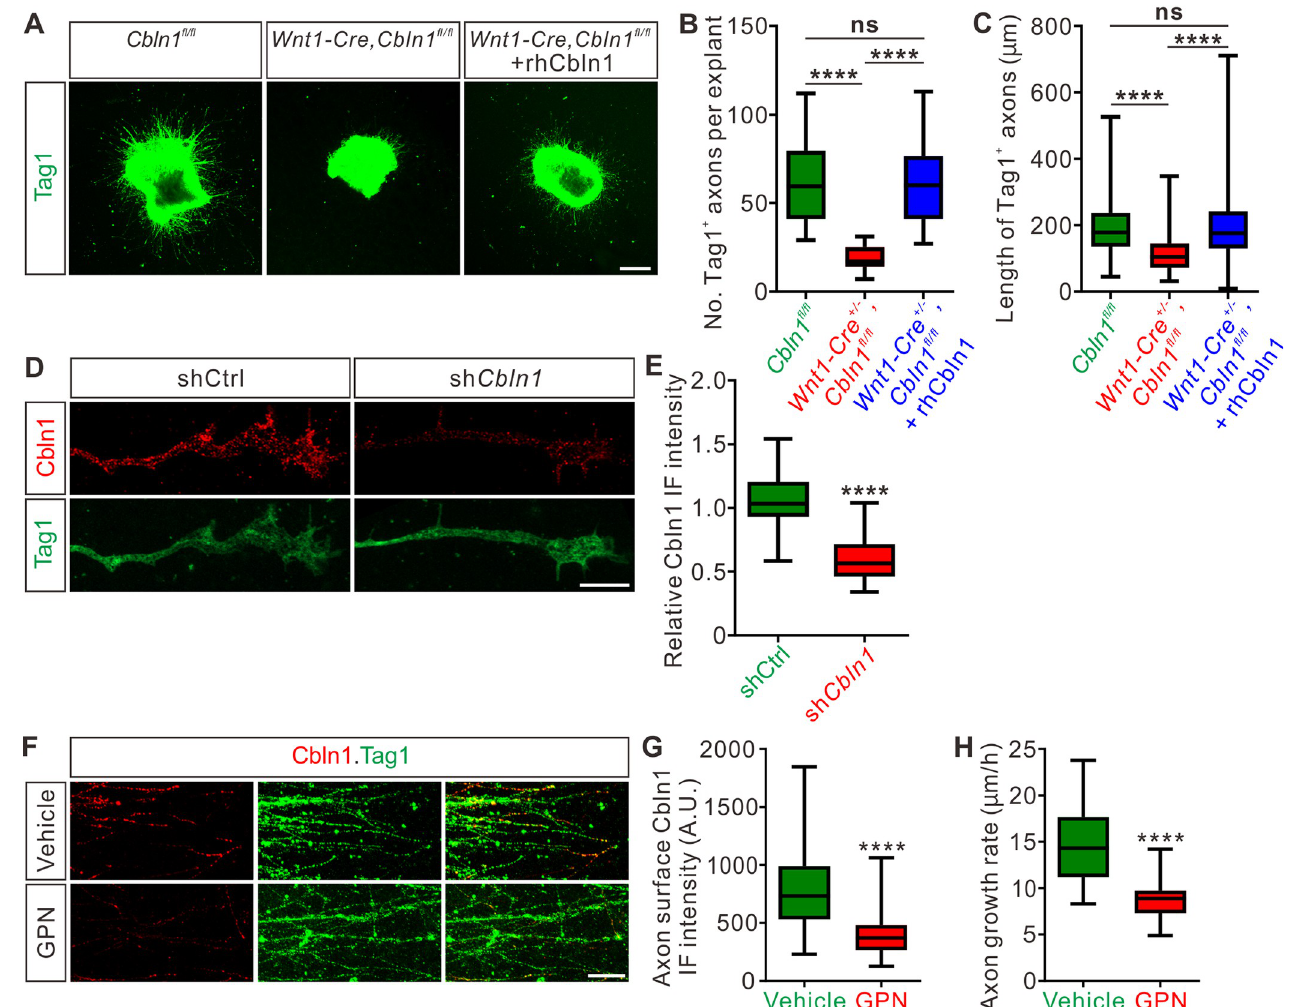
Fig 3. Cbln1 is secreted from commissural axon growth cones and stimulates commissural axon growth in an autocrine manner. ( A ) Extrinsic Cbln1 could rescue CA growth defects caused by cell-autonomous ablation of Cbln1 in the DCNs. DCN explants dissected from E10.5 mouse embryos were cultured in vitro and CA length was monitored by immunostaining of Tag1, a CA marker. Compared with Cbln1 fl/fl , DCN explants of Wnt1-Cre +/- , Cbln1 fl/fl embryos showed significant CA growth defects. These defects were rescued by adding the recombinant human Cbln1 protein (rhCbln1) to the cultures. Scale bar, 200 μ m. ( B and C ) Quantification of Tag1 + commissural axon numbers and lengths in (A). Data are represented as box and whisker plots. For B,